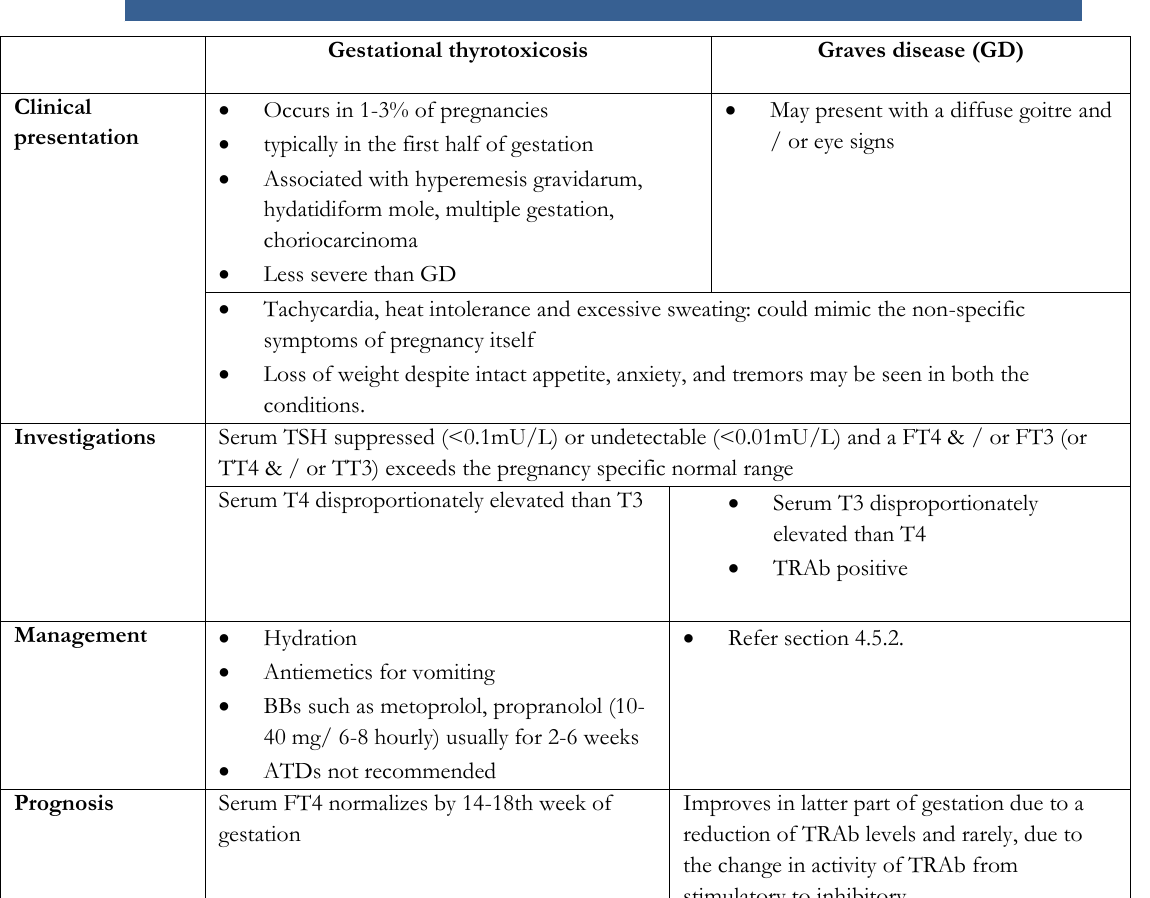
Table 4.7. Comparison of gestational thyrotoxicosis and Graves